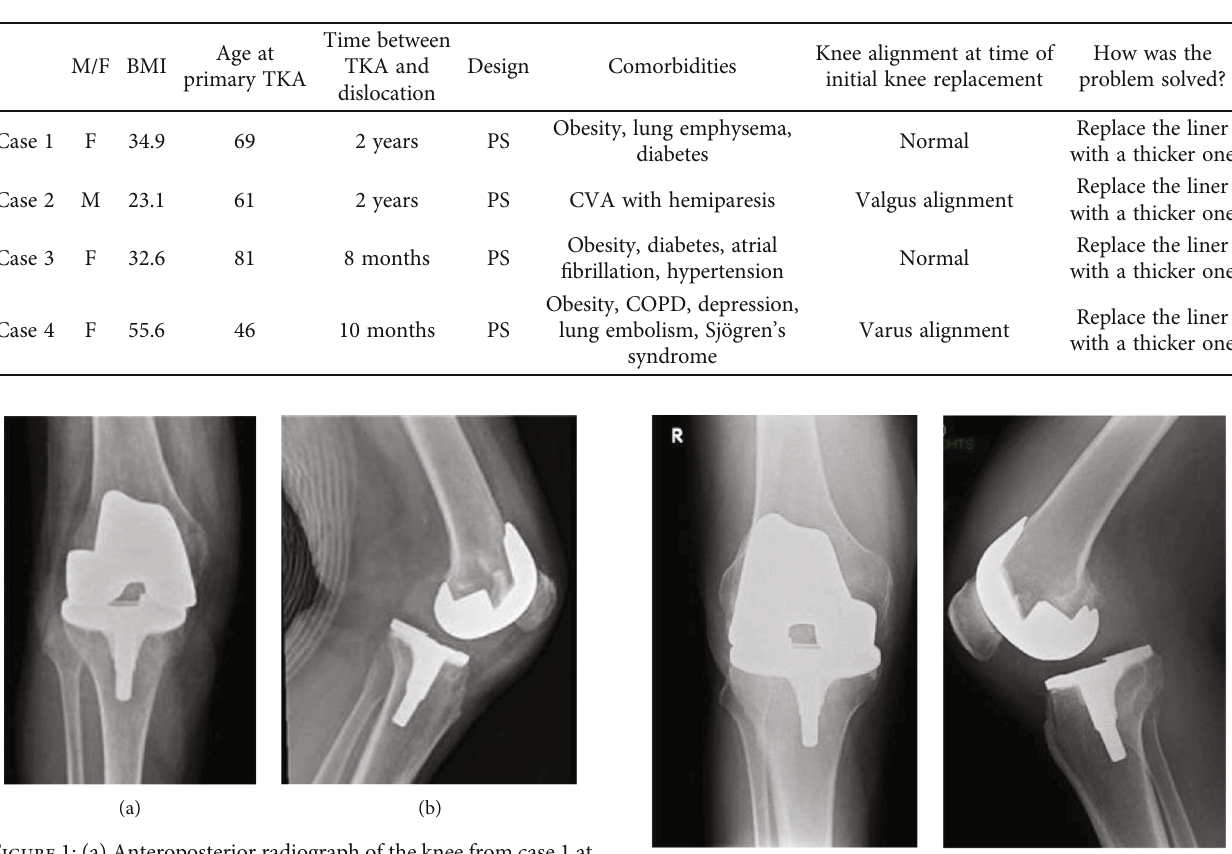
Table 1: Patient characteristics.